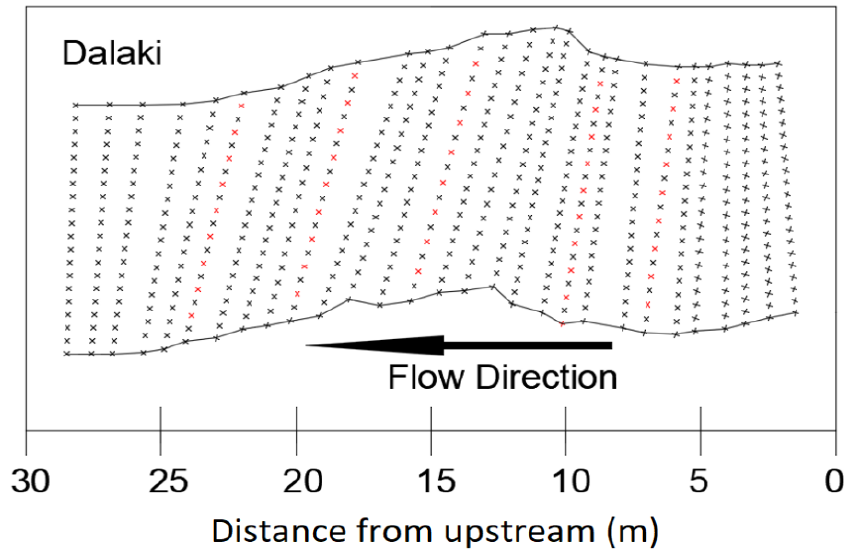
Figure 5. Plan of the studied reaches along with the position of the measured profiles.